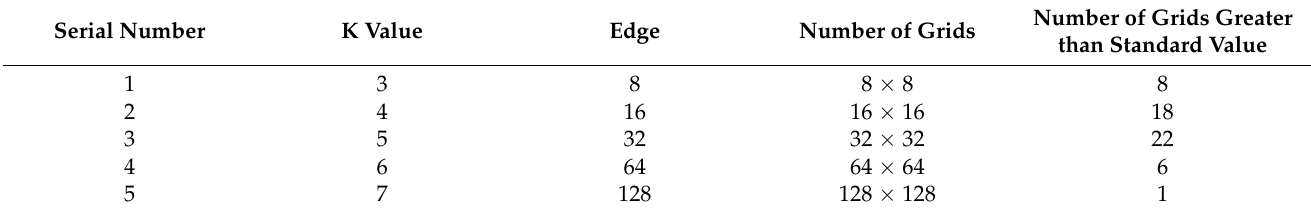
Table 3. Summary of experimental